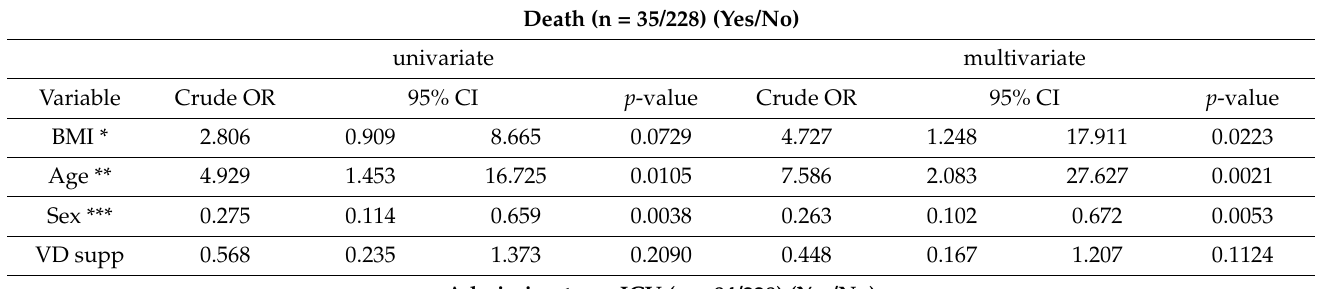
Table 4. Logistic regression analysis of association between clinical outcomes and covariates: impact of the pre-hospital vitamin D supplementation on COVID-19